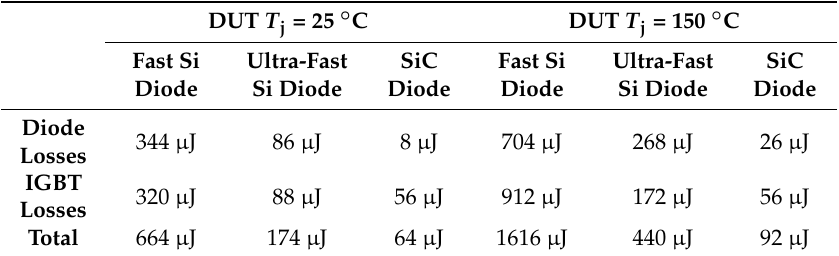
Table 1. Performance comparison of Si vs SiC diodes at 25 °C and 150 °C at 480 A/ μ s [28]. DUT: device under test. Reprint with permission [4062720248056]; Copyright 2003, IEEE.